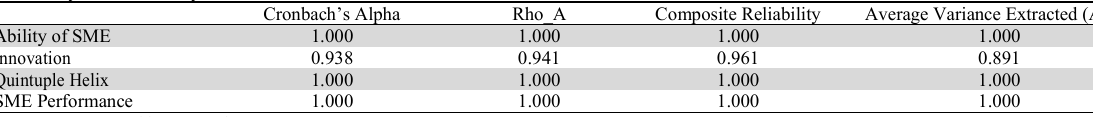
Reliability and Validity for fit model